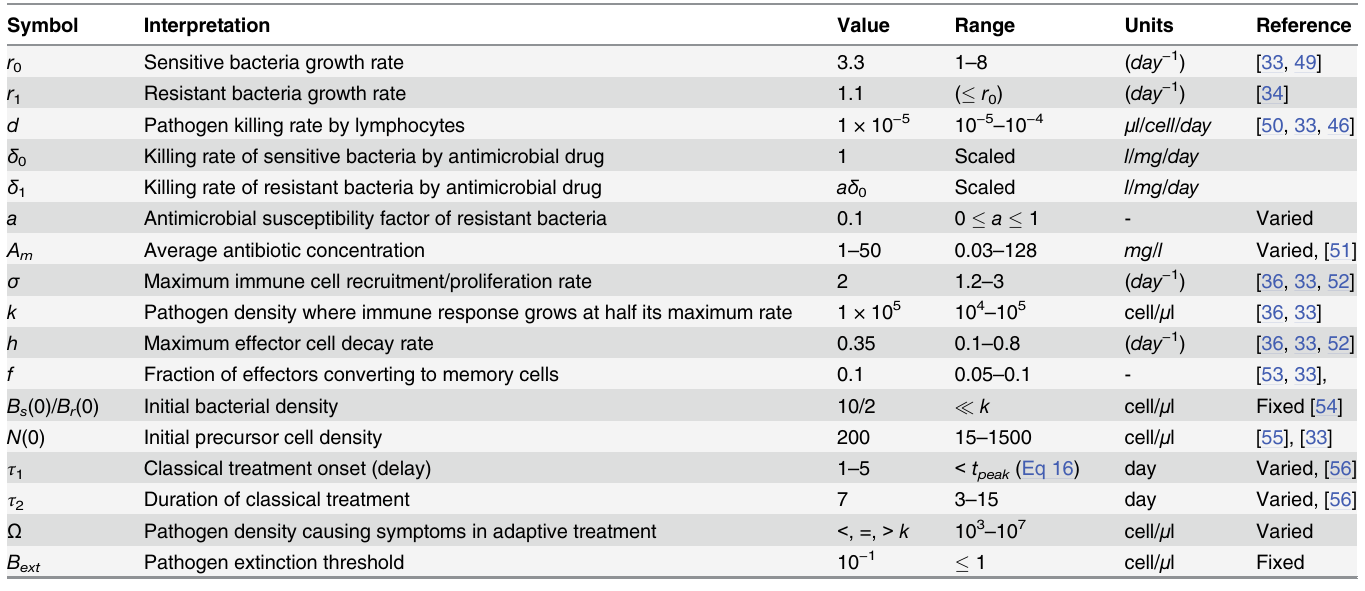
Table 1. Model parameters and